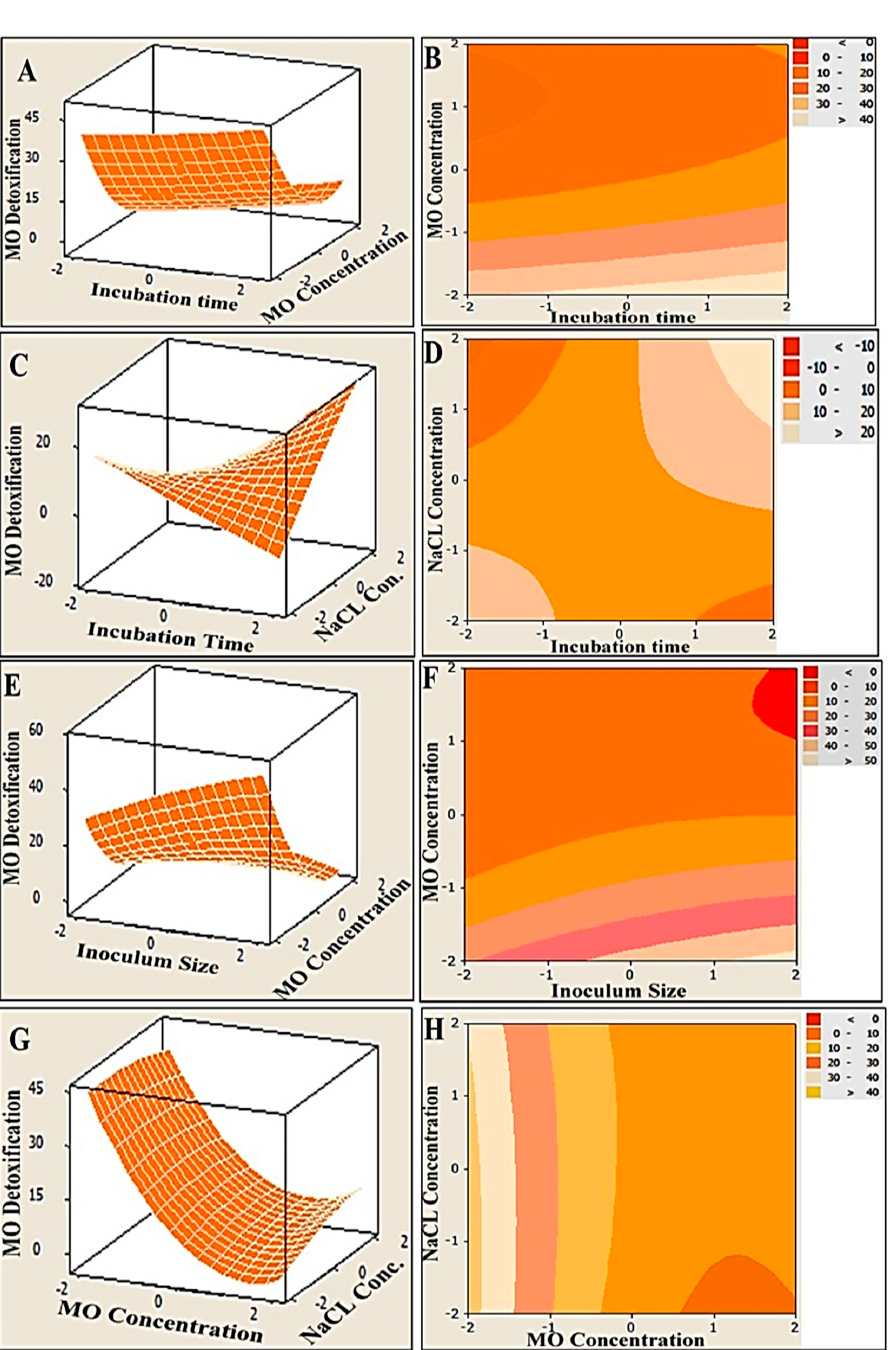
Figure 3. Three-dimensional surface and two-dimensional contour plots of MO degradation by immobilized consortium, showing the interactive impact of two variables at constant zero levels of the other variables. Both plots were created using MINITAB-14 software. A and B are the effect of incubation time and MO concentration on MO detoxification, C and D show obvious increase in MO detoxification with a mutual increase in both incubation time and NaCl concentration, E and F show antagonistic relationship between inoculum size and MO concentration, G and H show the maximum degradation of MO at a wide range of concentrations of NaCl and high range of MO concentrations.